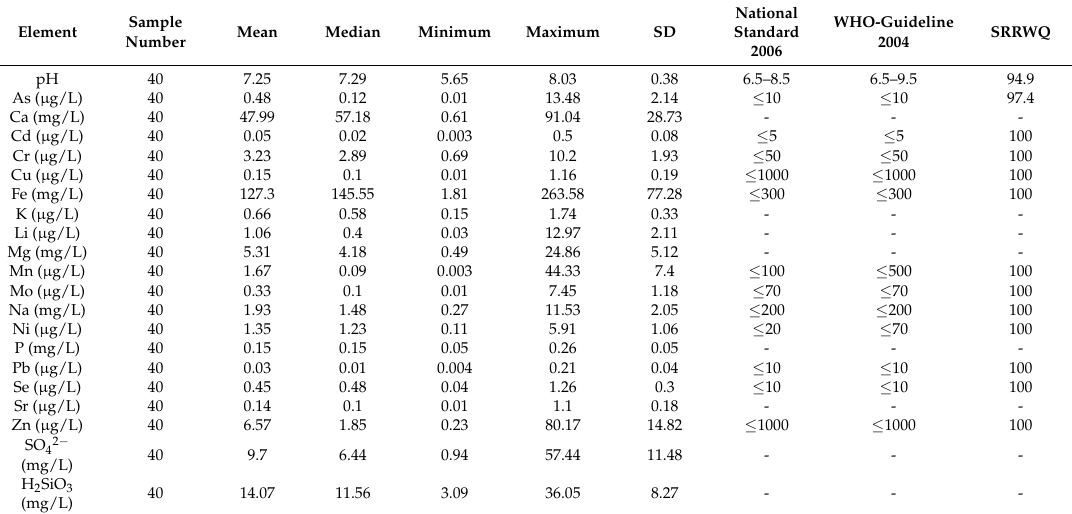
Table 2. Statistical analysis of trace element and mineral levels in drinking water in